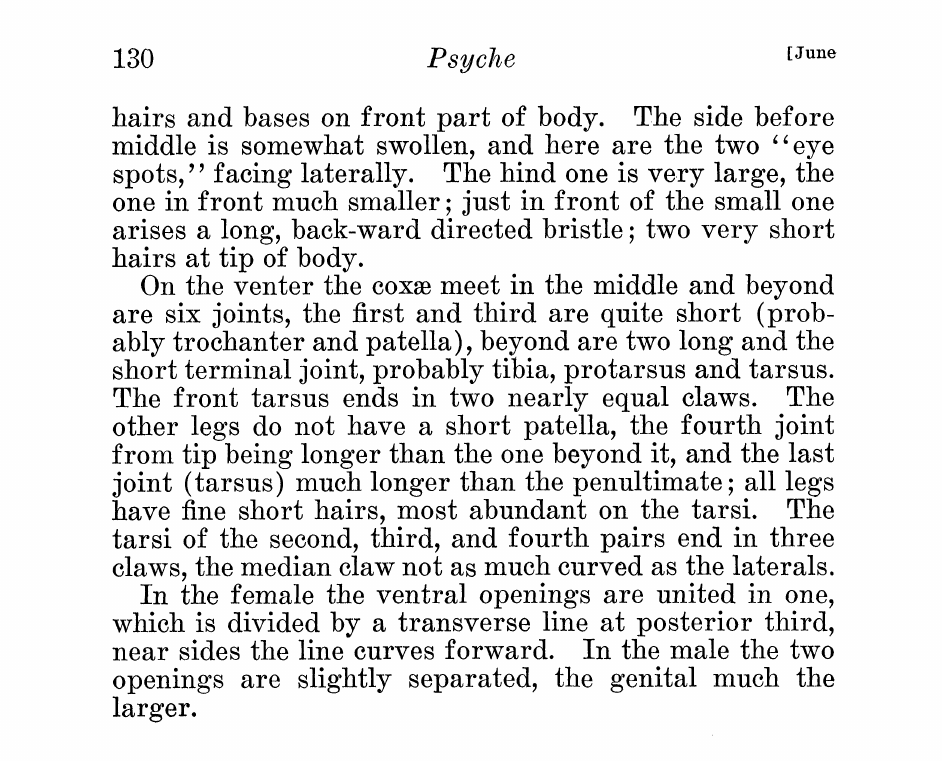
EXPLANATION OF PLATES